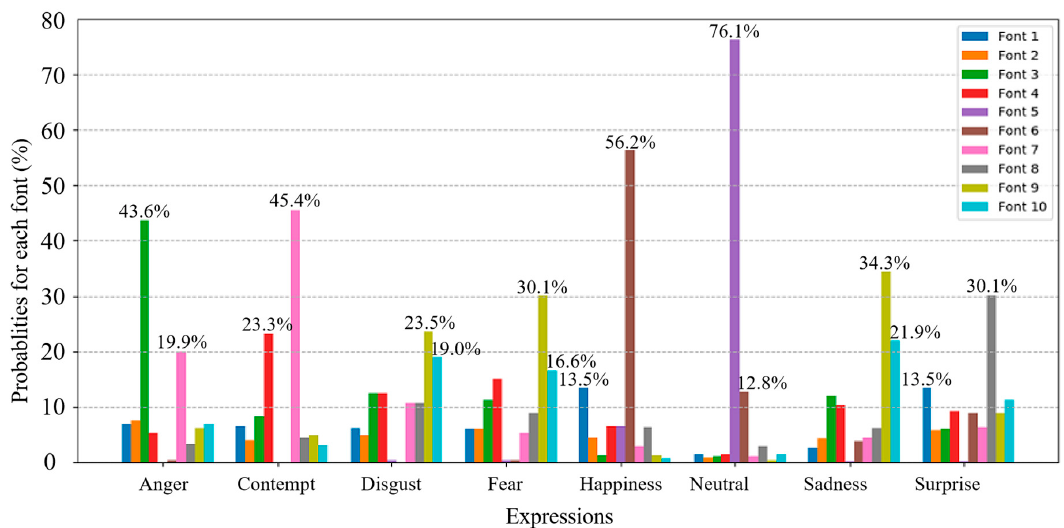
Figure 3. The main results of the questionnaire. For each emotion, the first two probabilities are marked, respectively.